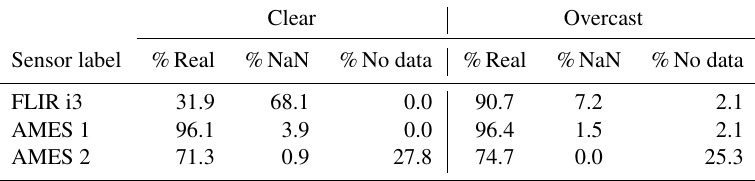
Table 1. Relative distributions of data types for real, not-a-number (NaN), and no data readings on the three sensors used in this study, broken down between clear-sky and overcast labels. The overall fractions of measurements classified as either clear-sky or overcast conditions are 73.5% and 26.5%, respectively. Clear Overcast Sensor